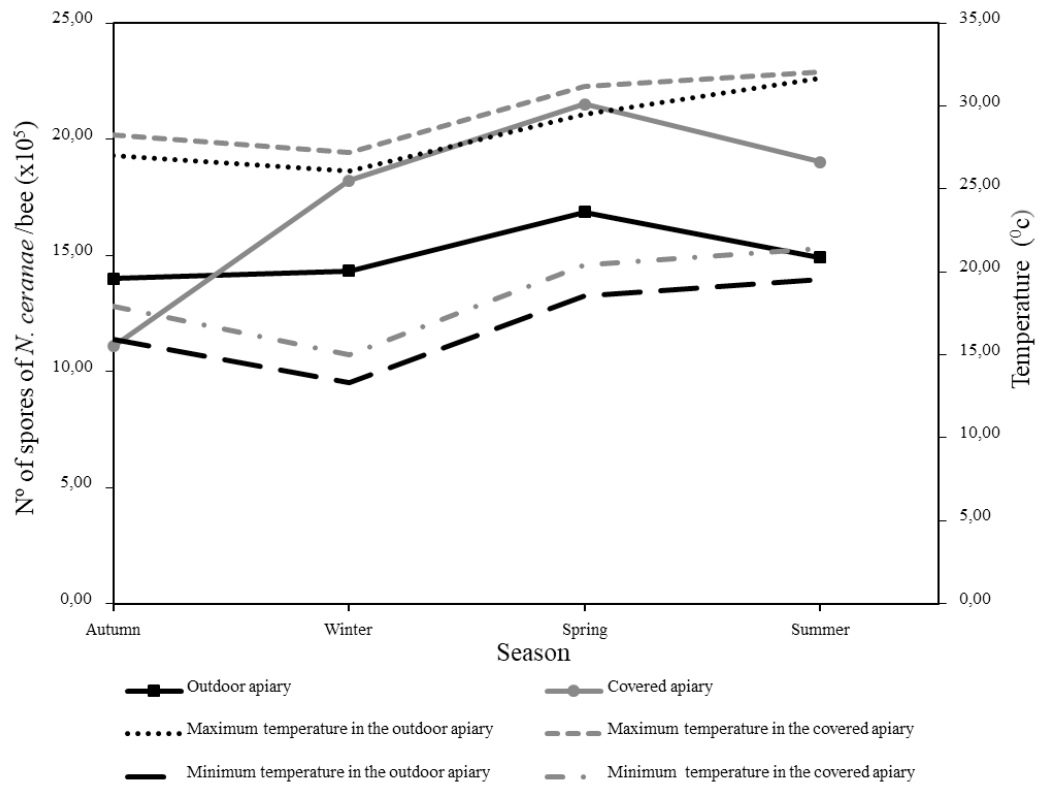
Fig 2 . Intensity of natural infection of Nosema ceranae (mean number of spores/bee x10 5 ) and maximum and minimum temperatures in hives located in outdoor apiary and covered apiary from August 2013 to August 2016 in relation to seasons.